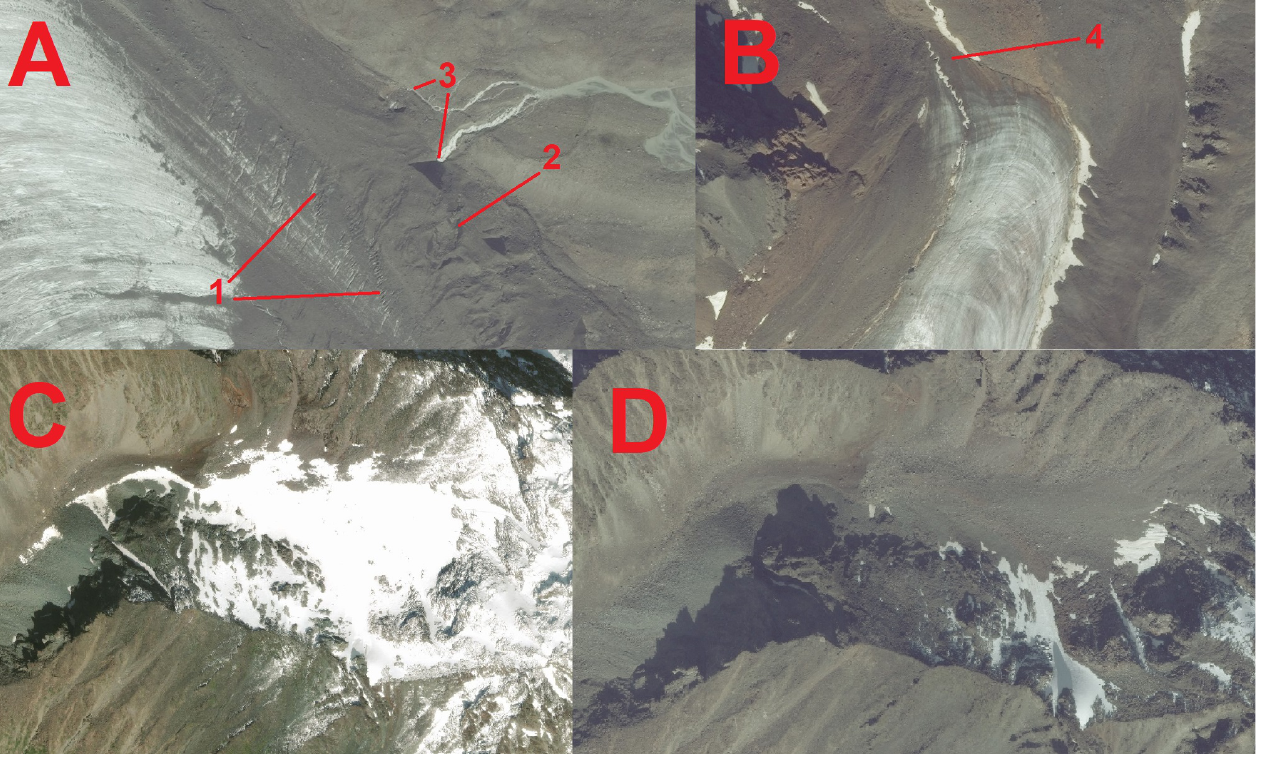
Figure 3. ( A ) Debris-covered part of Bolshoi Maashei glacier and the dead ice. 1—crevasses, marking the debris-covered part of the glacier; 2—thermokarst forms; 3—tunnels, both marking the dead ice areas: ( B ) debris-covered edge of glacier No. 138 (Aktru river basin); 4—the “smooth” debris surface; ( C ) seasonal snow cover and a large snowpatch (Maashei river valley); ( D ) the same area at the end of the ablation